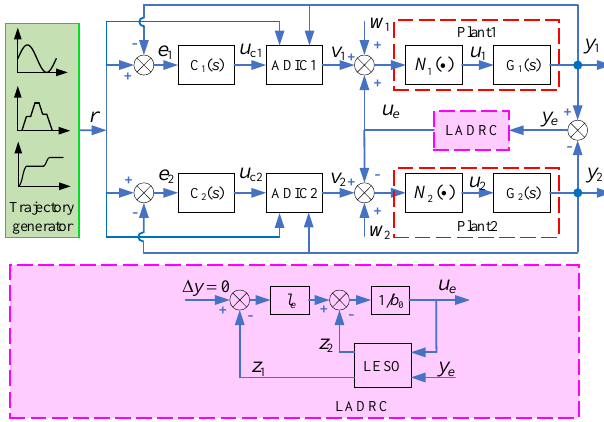
Figure 6. Structure block diagram of the position synchronization control system.